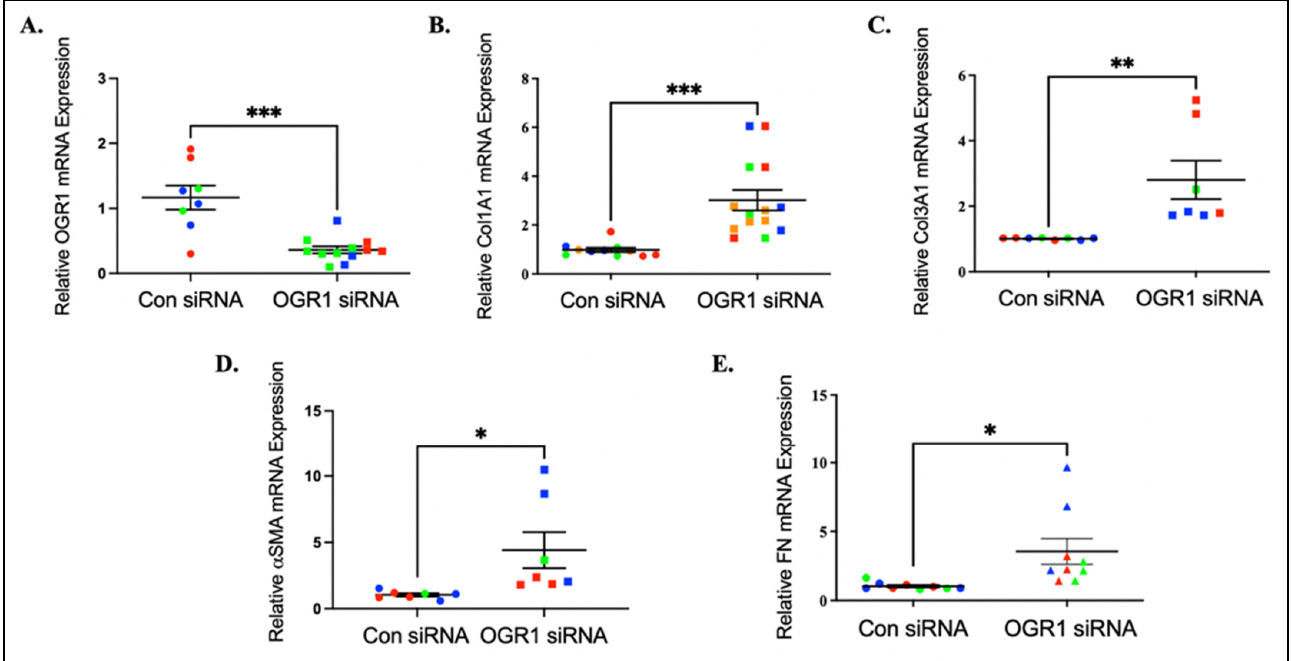
Figure 2. Knocking down OGR1 expression, through siRNA, causes pro-fibrotic gene expression. Healthy human lung fibroblasts were treated with non-targeting or OGR1 siRNA. The expression of OGR1 ( A ), collagen 1A1 ( B ), collagen 3A1 ( C ), α -SMA ( D ), and fibronectin ( E ) were subsequently assessed by qRT-PCR. Results are displayed as candidate mRNA expression relative to 18 S, each set of colors represent a unique cell line isolated from different donors. Data represent mean expres- sion ± SEM (n = 3/treatment group, repeated in triplicate in three different cell lines). *** p = 0.0001 ( A ), *** p = 0.0003 ( B ), ** p = 0.0058 ( C ), * p = 0.0303 ( D ), * p = 0.0165 ( E ).